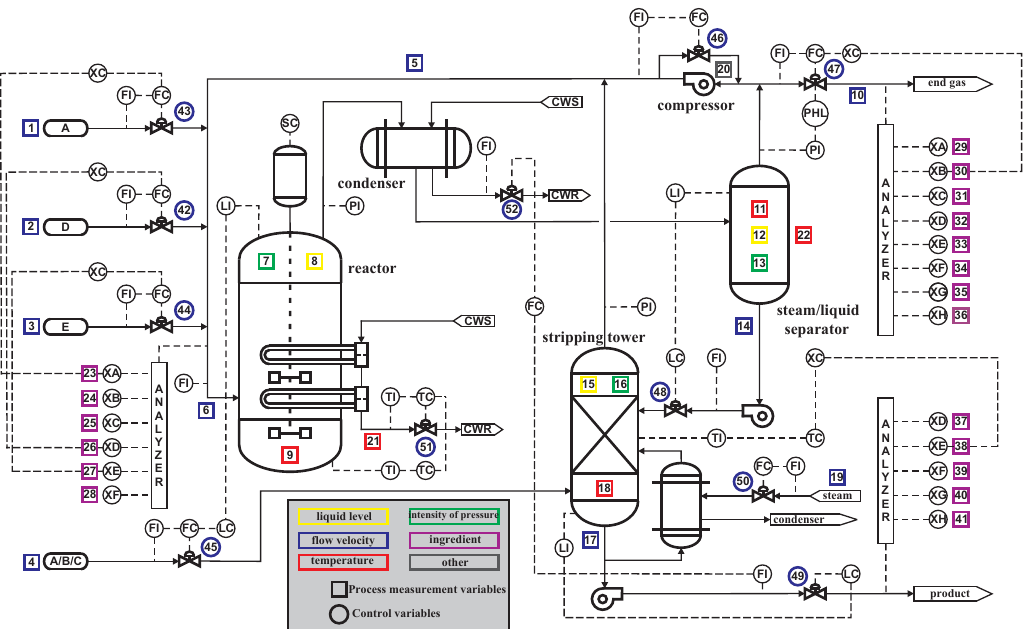
Figure 6. Tennessee-Eastman Process (TEP) industrial equipment flow